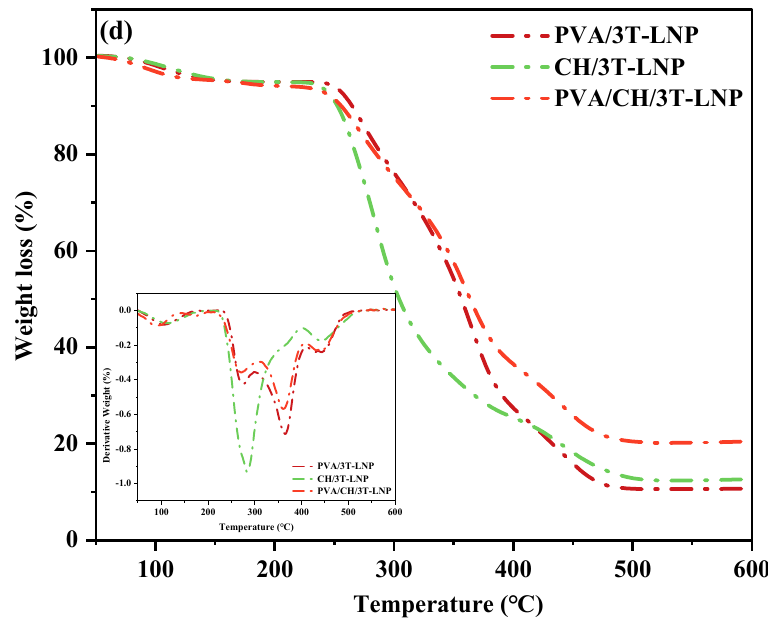
Figure 10. TG and DTG curves of ( a ) PVA, ( b ) CH, ( c ) PVA/CH based composite materials with different amount of LNP; ( d ) Comparison between the binary and ternary composite films. Table 7. Detailed TG parameters for PVA, CH and LNP composited films.